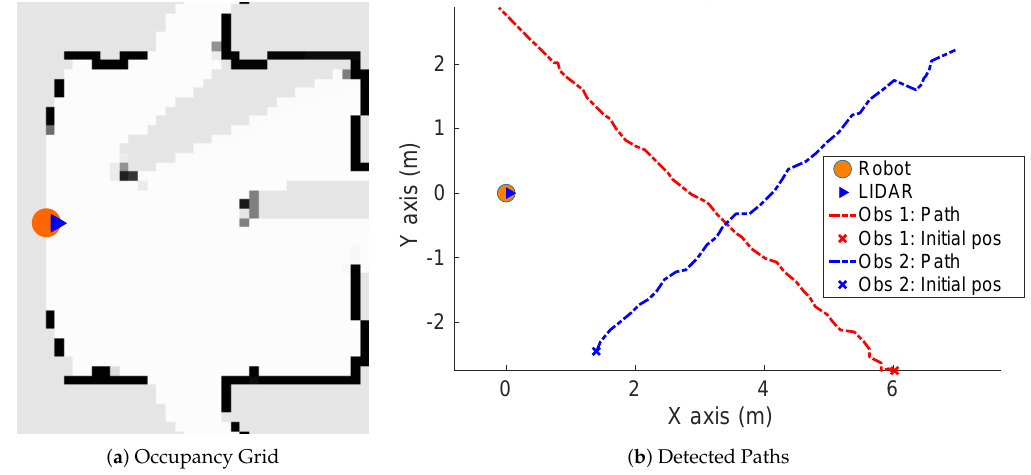
Figure 15. Real scenario 2—Occupancy Grid and Paths